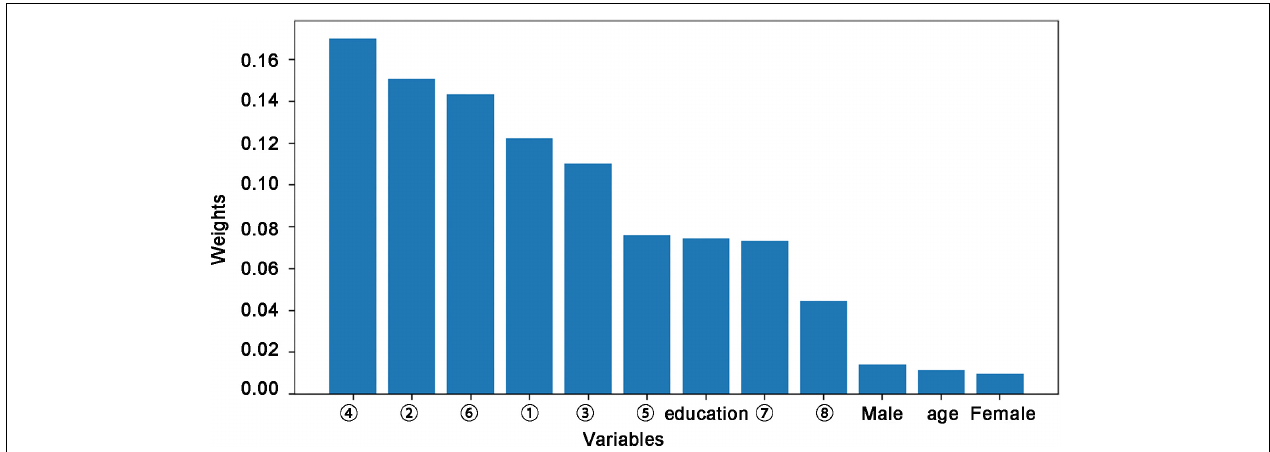
FIGURE 2 | Feature importance across rs-fMRI features and demographic data included in the random forest algorithm for the prediction of DNR. (cid:192) - (cid:199) represents a number of FC variables: (cid:192) PCC.R–middle frontal gyrus.R; (cid:193) PCC.R–middle frontal gyrus.L; (cid:194) mPFC.R–MCC.L; (cid:195) Lateral parietal cortex.L–calcarine.R; (cid:196) Insula.R–superior occipital gyrus.R; (cid:197) Anterior prefrontal cortex.L–MCC.L; (cid:198) Ventral hippocampus.L–inferior parietal gyrus.R; (cid:199) Amygdala.L–superior temporal gyrus.L. DNR, delayed neurocognitive recovery; FC, functional connectivity; MCC, middle cingulate cortex; mPFC, medial prefrontal cortex; PCC, posterior cingulate cortex; rs-fMRI, resting-state functional MRI; R, right; L, left.